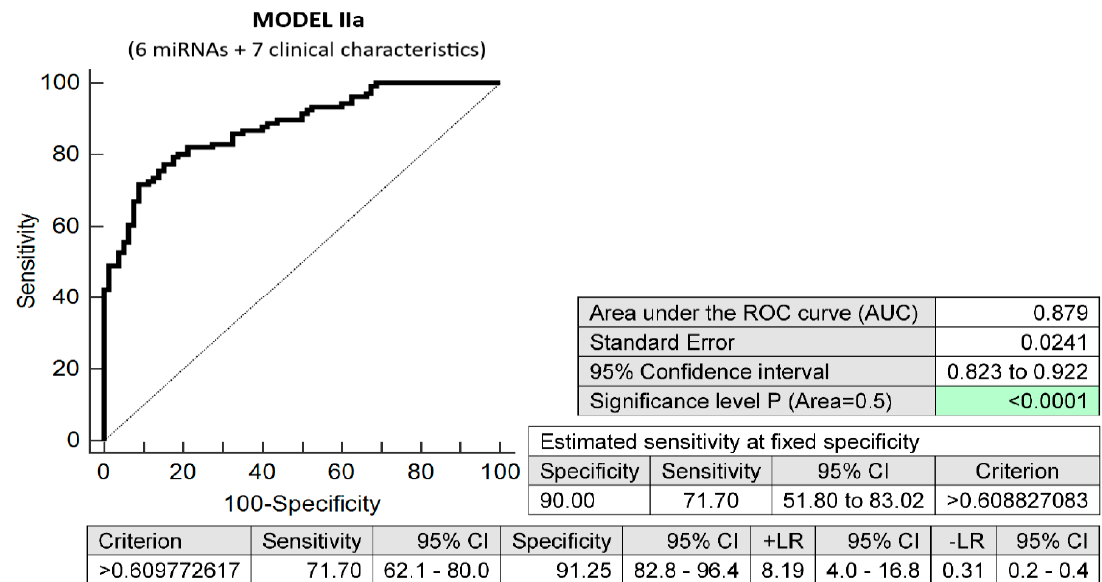
Figure 4. ROC analysis—prediction model IIa for preterm birth before 37 gestational weeks. Combination of seven maternal clinical characteristics (maternal age and BMI values at early stages of gestation, infertility treatment with assisted reproductive technology, the occurrence of preterm delivery before 37 gestational weeks in previous pregnancy(ies), the presence of any kind of autoimmune disease (rheumatoid arthritis, systemic lupus erythematosus, antiphospholipid syndrome, type 1 diabetes mellitus, or other autoimmune disease), positive first-trimester screening for early PE before 34 gestational weeks and/or FGR before 37 gestational weeks using FMF algorithm, and positive first-trimester screening for PTB before 34 gestational weeks using FMF algorithm) and six dysregulated microRNA biomarkers (miR-16-5p, miR-21-5p, miR-24-3p, miR-133a-3p, miR-155-5p, and miR-210-3p). In total, 71.70% of pregnancies destined to deliver before 37 gestational weeks were identified during the first trimester of gestation with a 10.0% FPR.